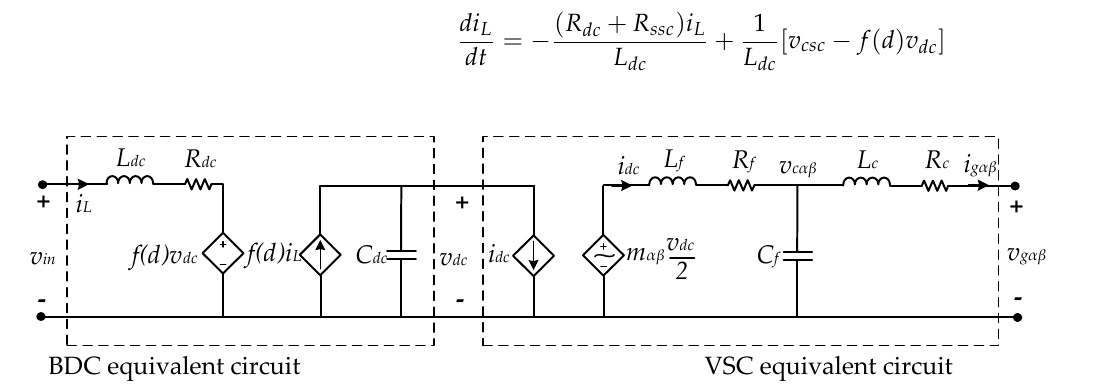
Figure 8. Equivalent circuit model for power stage of the BDC and VSC.